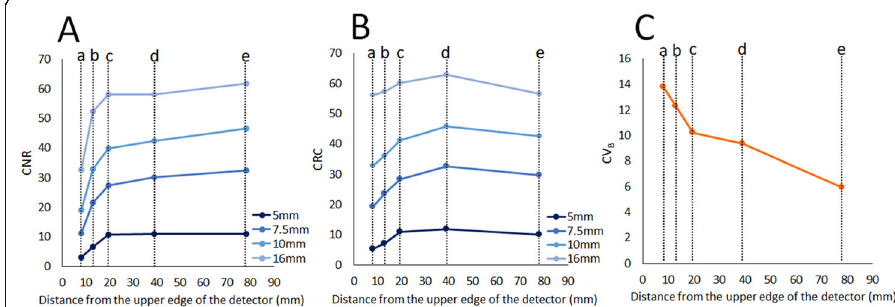
Fig. 4 Quantitative assessment of the breast phantom scanned by dbPET at the five different positions. Line graphs of CNR ( A ), and CRC ( B ), and CV B ( C ) of the breast phantom images for the 5 mm, 7.5 mm, 10 mm, and 1 mm spheres scanned by dbPET at the five different positions are shown. The a, b, c, d, and e on the X -axis correspond to phantom positions of 8 mm, 13 mm, 19.5 mm (depth of 1/8), 39 mm (depth of 1/ 4), and 78 mm (depth of 1/2, the centre of the detector) below the top edge of the